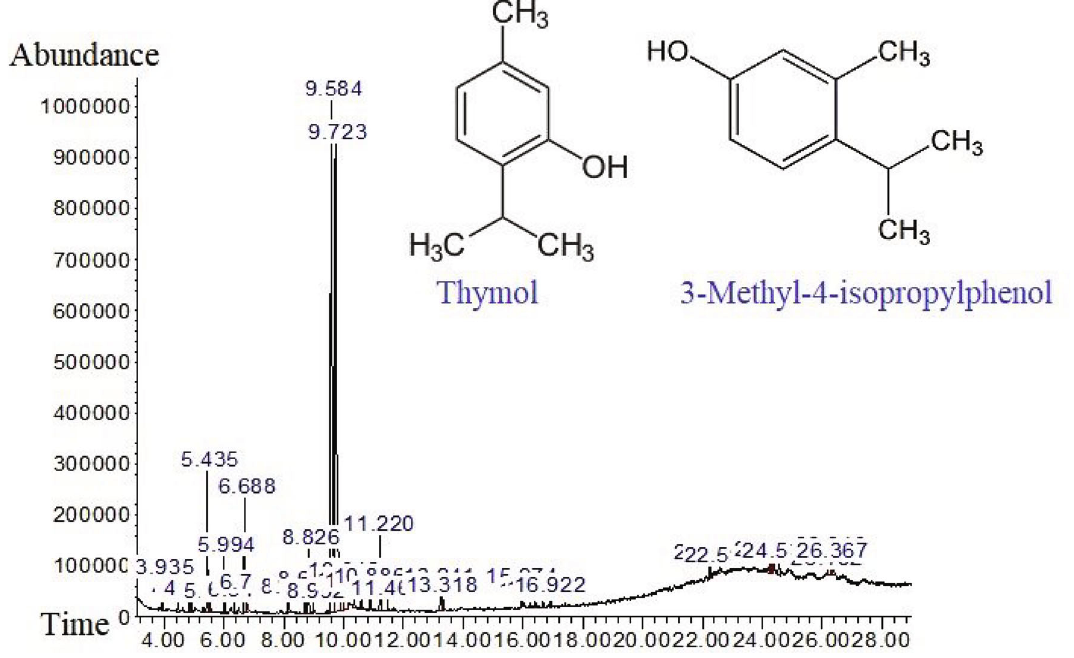
Figure 5: E ff ective ingredients of ethanolic extract of